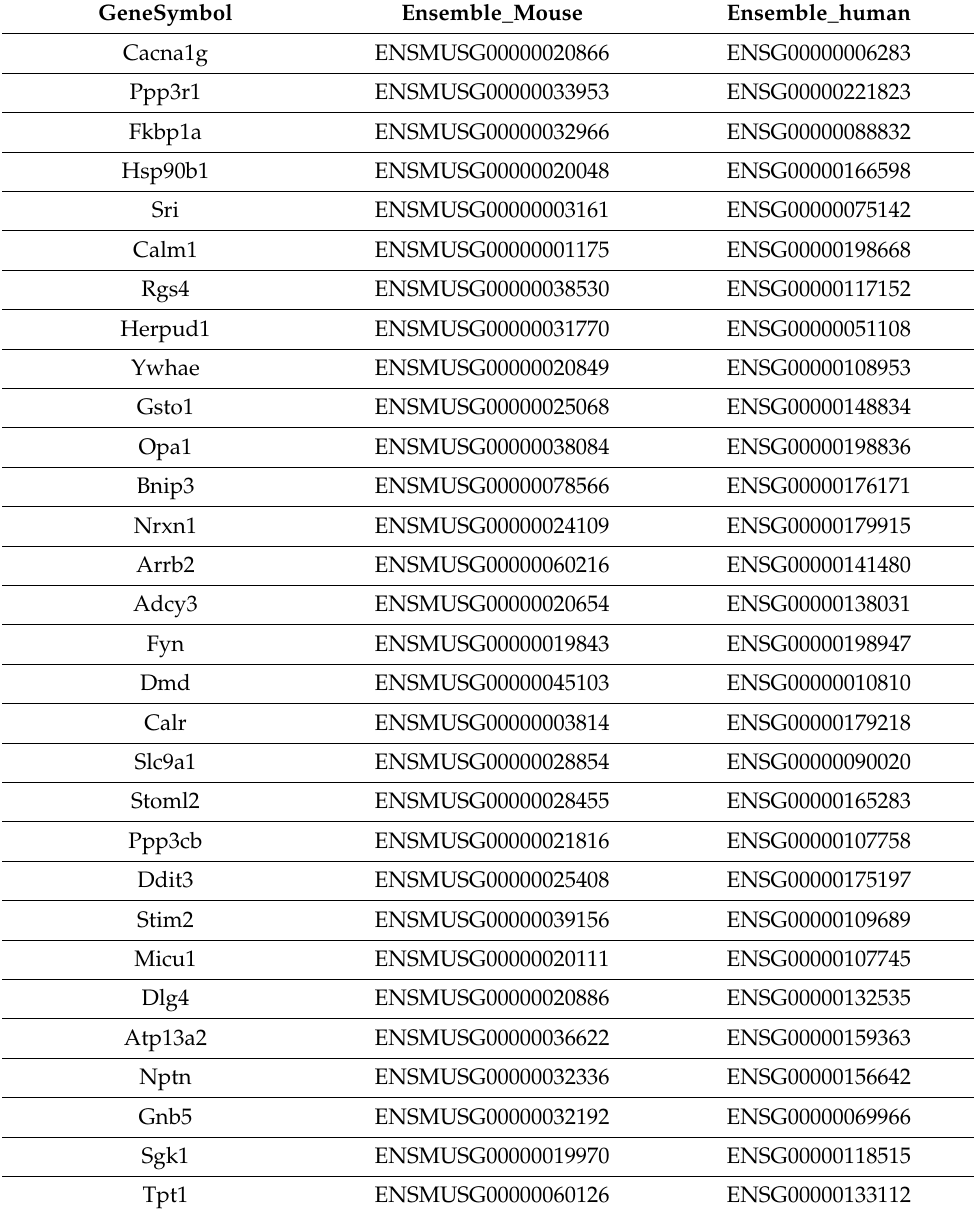
Table 4. Calcium-regulating signature genes identified in AS model